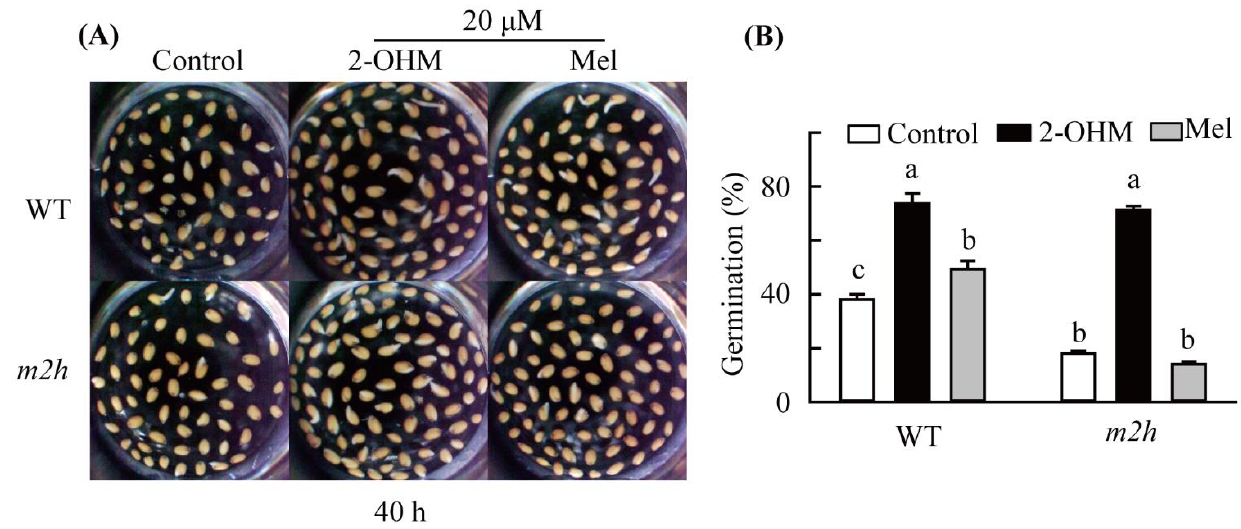
Figure 7. Gain-of-function analysis of m2h knockout mutant seed germination following exogenous 2-hydroxymelatonin (2-OHM) treatment. Non-dormant A. thaliana WT and m2h knockout mutant seeds were germinated with 2-OHM (20 μ M) or without 2-OHM (Control) at 25 °C for 40 h. ( A ) Photographs of germinated seeds upon various chemical treatments at 40 h after imbibition. ( B ) Quantification of germination in ( A ). Error bars indicate standard deviation (SD) of three biological replicates. Different letters indicate significant differences ( p < 0.05; ANOVA, followed by Tukey’s HSD post hoc tests).